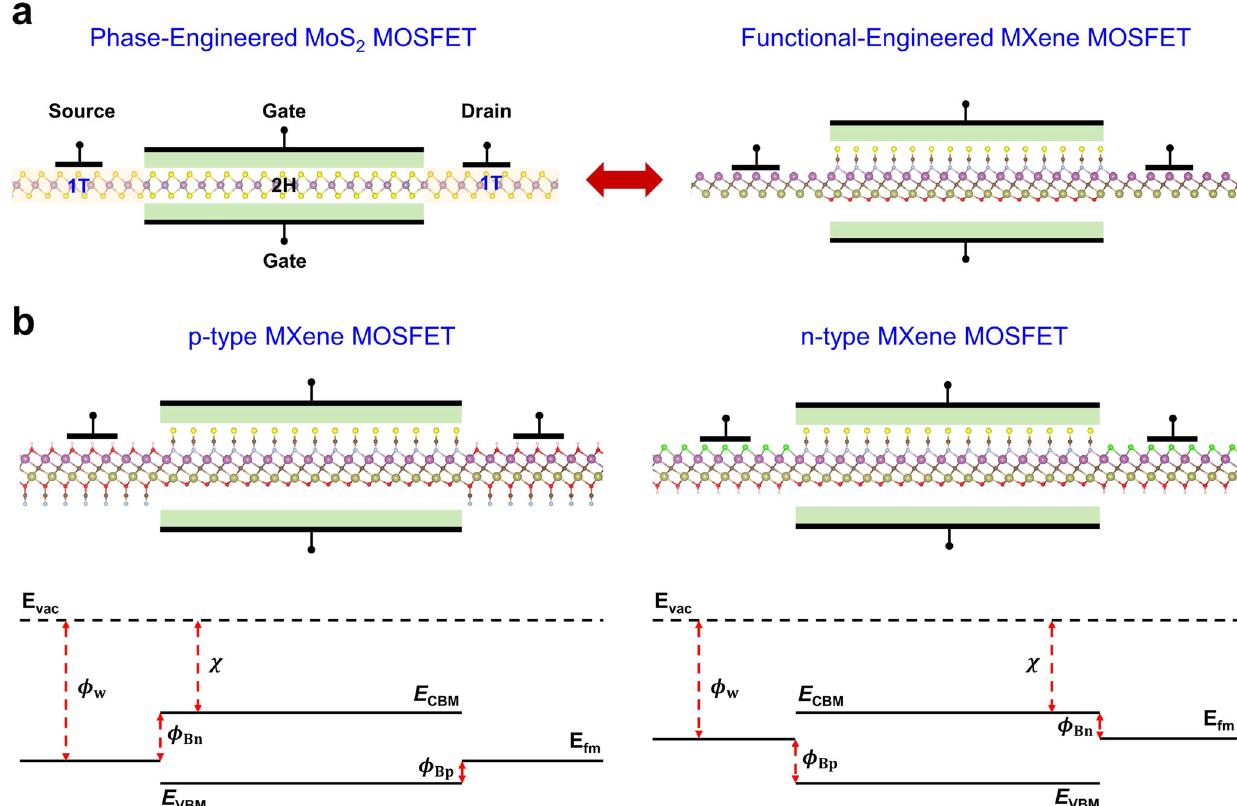
Fig. 2 Concept of functional-engineered MOSFET. a an analogy with phase-engineered MoS 2 transistor b complementary p and n-type transistor with source and drain functionalization with their schematic band diagram. Here, E vac ; E fm ; E CBM and E VBM represent energy levels for vacuum, Fermi, conduction band minima, and valence band maxima,